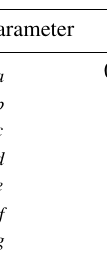
Table 2. Static parameter values for the Tóth et al. (2015) pedo- transfer functions used in experiments.